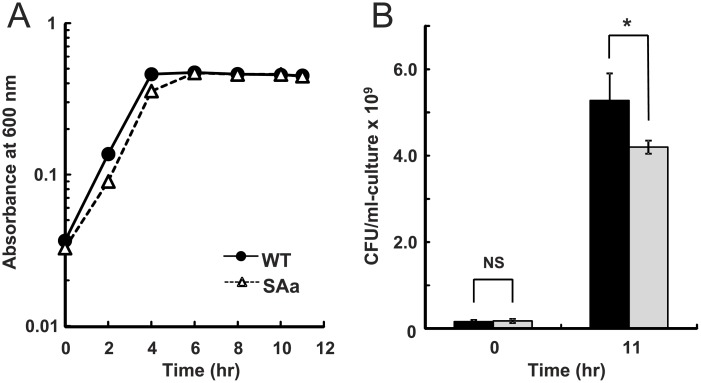
Effects of knockout of the cox genes encoding the caa3 oxidase.(A) Growth profiles of the WT (filled circles) and cox mutant strain SAa (open triangles) under carbon-limited conditions. The strains were grown aerobically in 3 ml of synthetic medium supplemented with 0.6 g/l glucose in test tubes with shaking at 200 rpm. (B) Colony-forming units (CFU) of the strains on LB plates. CFUs were counted immediately after inoculating the cells and after cultivation for 11 h in synthetic medium supplemented with 0.6 g/l glucose. Black and gray bars indicate WT and SAa, respectively. The results represent the means based on three measurements. Error bars indicate standard deviations of the means. Asterisk indicates that the mean values are significantly different by unpaired two-tailed Student’s t test (p<0.05). NS indicates that the means of the two samples are not significantly different.